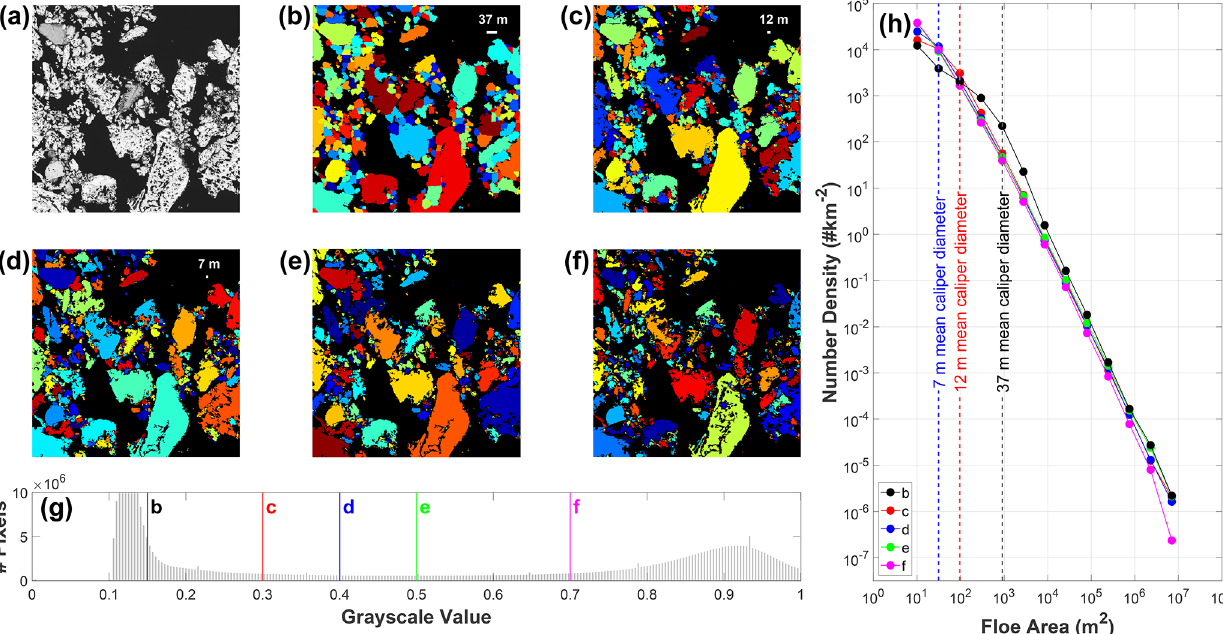
Figure 2. Comparison at the small-floe scale of segmentation of an MIZ MEDEA image from 11 August 2014 using different parameters. (a) A 750m × 750m subregion of the image showing heavily ponded, broken ice and open water; (b) through (f) segmentations of the same subregion obtained by applying grayscale thresholds (on a scale of 0 to 1) of 0.15, 0.3, 0.4, 0.5, and 0.7, respectively; (g) histogram of pixel grayscale values (scaled from 0–255 to 0–1) for the overall image showing the location of grayscale thresholds for (b) (black) through (f) (magenta); and (h) floe size distributions of (b) (black) through (f) (magenta). Vertical lines are shown at scales shown in (b) through (d) , which correspond to the size of artifact floes in